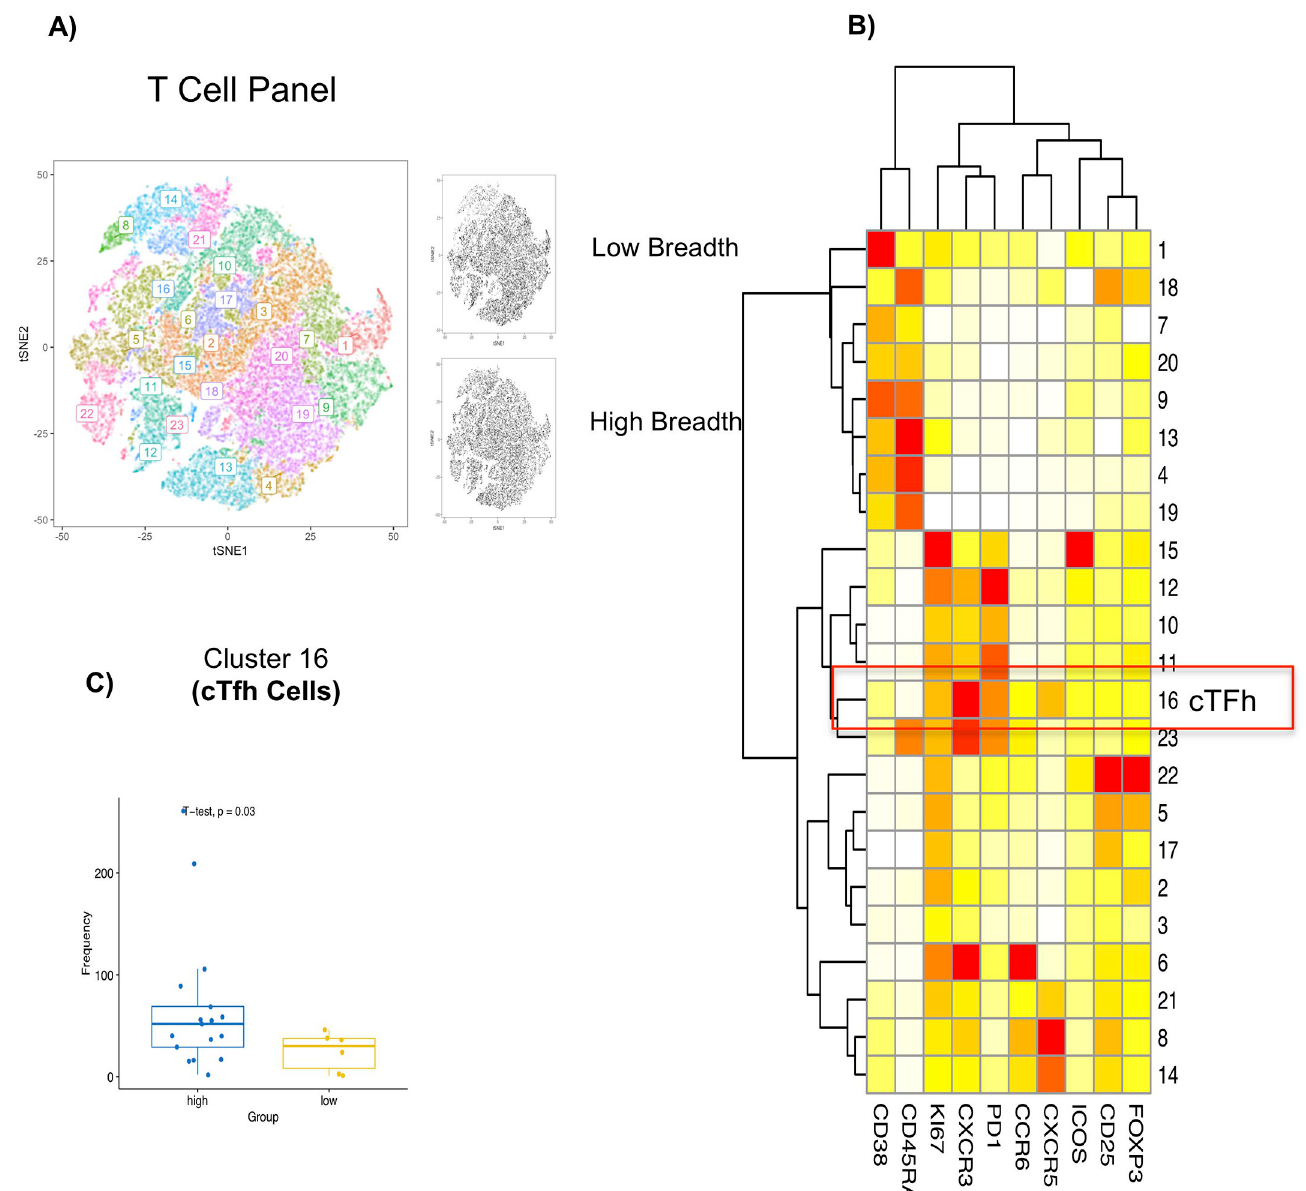
Fig 4. Pre-vaccination frequency of total cTfh positively correlates with the breadth of the vaccine response. (A) Cell cluster distribution depicts 23 separate distinctive clusters . (B) Heatmap of the 23 different clusters expressing different phenotypes using the optimized T cell panel with markers denoted in the X-axis. Cluster 16 represents a cTfh cluster. (C) Boxplot of the significant cluster (cluster 16) investigating the cluster with the breadth of the vaccine response. Subjects who mounted neutralizing antibodies against all four serotypes (termed “high” breadth) were compared to subjects who mounted neutralizing antibodies against < 3 serotypes (termed “low” breadth). Cells were gated on live CD4+CD3+ cells and the expression was scaled and used to perform clustering and was visualized using t-Distributed Stochastic Neighbor Embedding (tSNE). Cell frequency per cluster/ per sample was derived and used for statistical testing between high and low breadth across donors. Day 0 donor samples were associated with breadth of the response post vaccination. Welch’s T-test was performed for the breadth of vaccine response (C) . Nominal p-values p < 0.05 were considered statistically significant. � p < 0.05, �� p < 0.01 and ��� p < 0.001. ���� p < 0.0001. Tfh cells robustly correlated with the breadth of Dengue virus specific neutralizing antibodies induced upon vaccination as represented by cluster 16. This analysis confirmed that cTfh fre- quencies are statistically significantly (p < 0.05) higher in “high” subjects compared to “low”